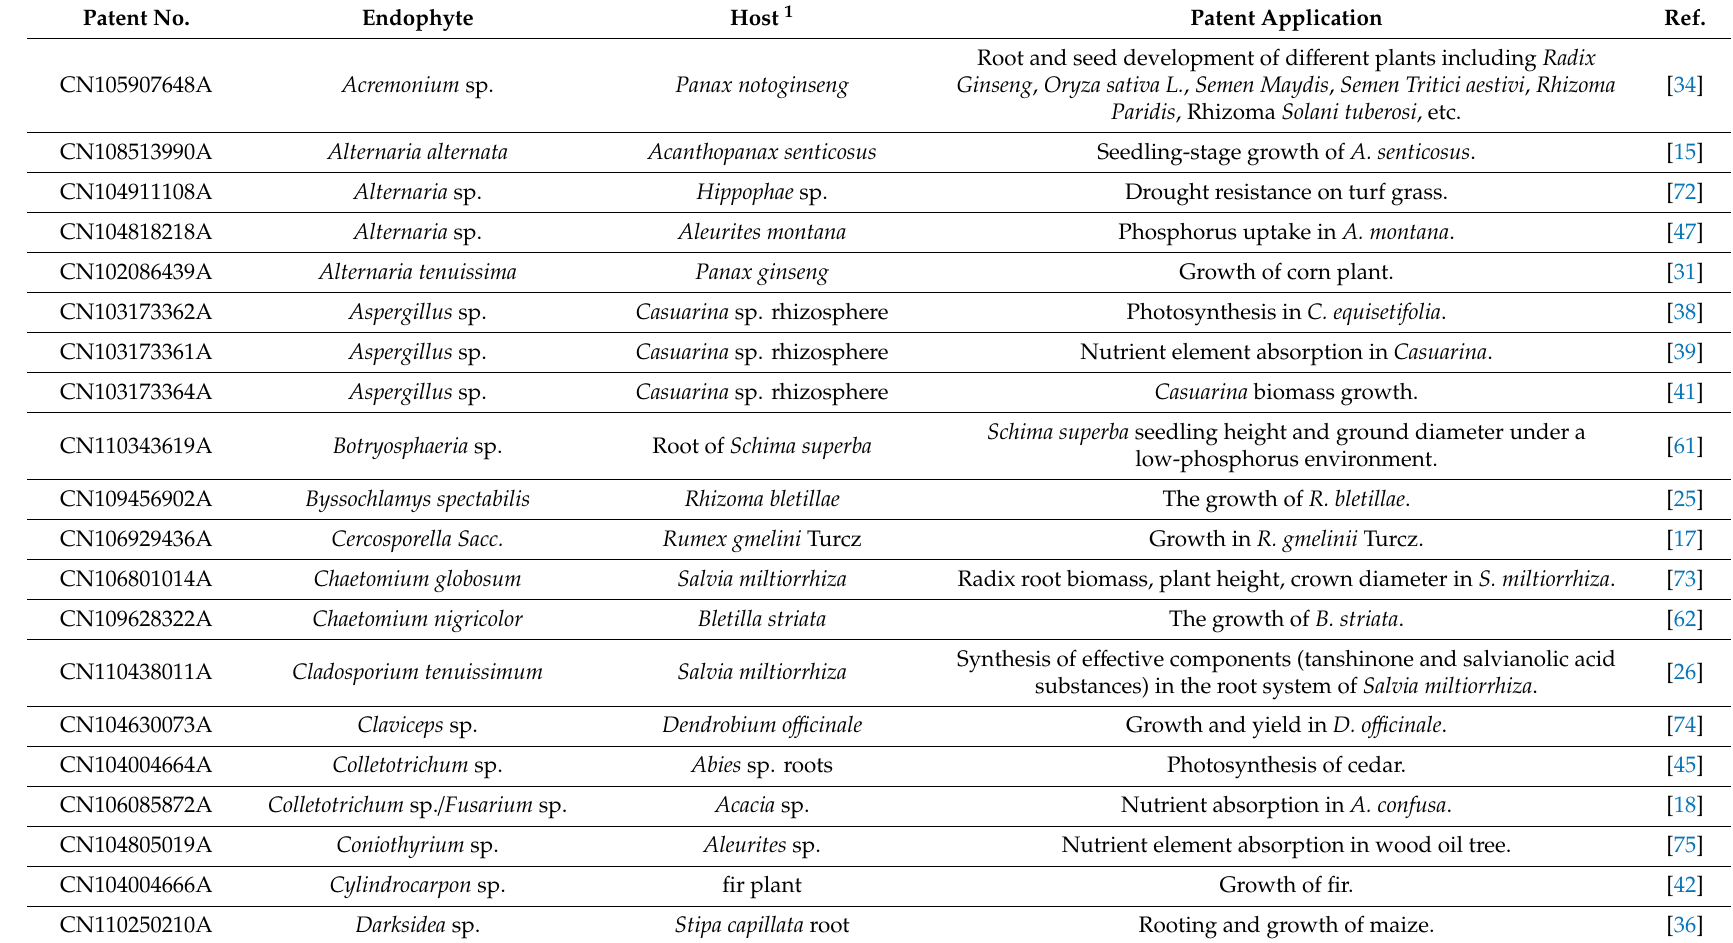
Table 2. Endophytic fungi applied for the growth promotion of